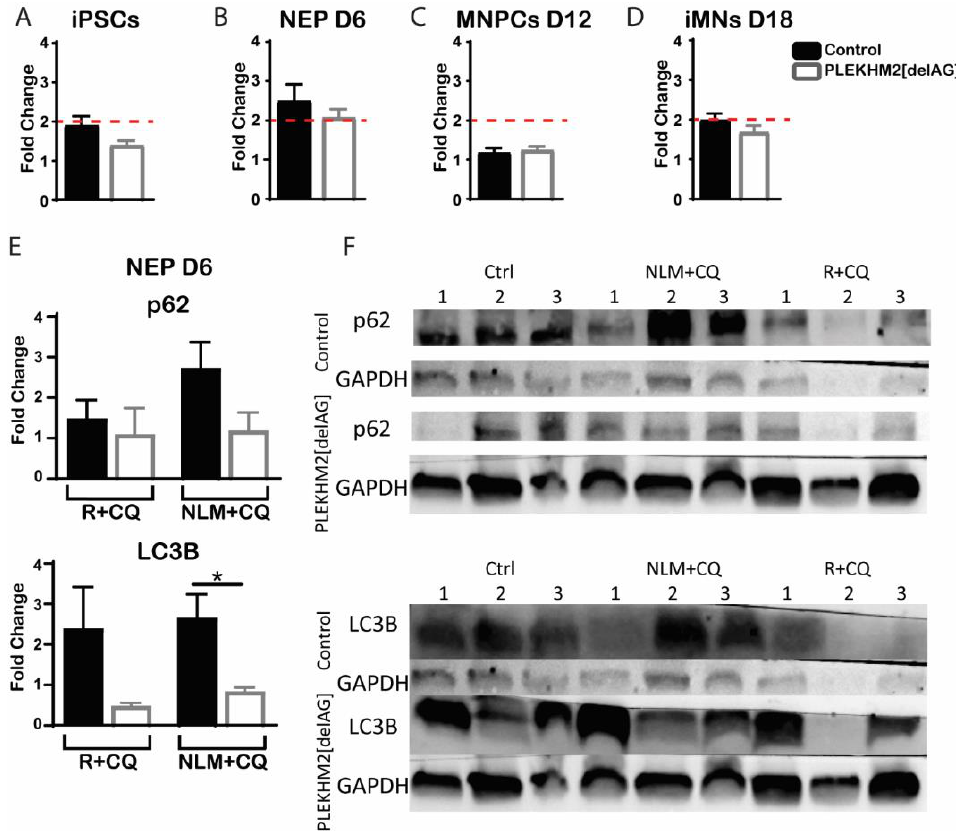
Figure 3. Reduced autophagic activity trend in PLEKHM2[delAG] cultures. ( A – D ), Autophagy flux acquired by flow cytometry analysis during four stages of differentiation using the CYTO-ID au- tophagy detection kit. iPSCs ( A ), NEP ( B ), MNPCs ( C ), and iMNs ( D ). Stress induction by rapamy- cin and chloroquine (R + CQ) treatment, unless stated otherwise. Black and empty bars represent control and PLEKHM2[delAG] cultures, respectively. Fold change calculated by median fluorescent intensity after treatment normalized to untreated samples. The dashed red line marks the 2-fold change. Two- tailed student’s t -test was employed, presenting mean ± SEM n > 3. ( E ) Western blot analysis of D6 culture autophagosome markers p62 and LC3B under two stress inductions, R + CQ and nutrient limited media with chloroquine (NLM + CQ). * p = 0.0155 by two- tailed student’s t -test. Bar graphs present mean ± SEM n = 5 (including 2 – 3 technical repetitions in at least two independent experiments for each line) ( F ) Representative Western blots. Autophagosomal markers, p62 and LC3B and housekeeping gene, GAPDH.